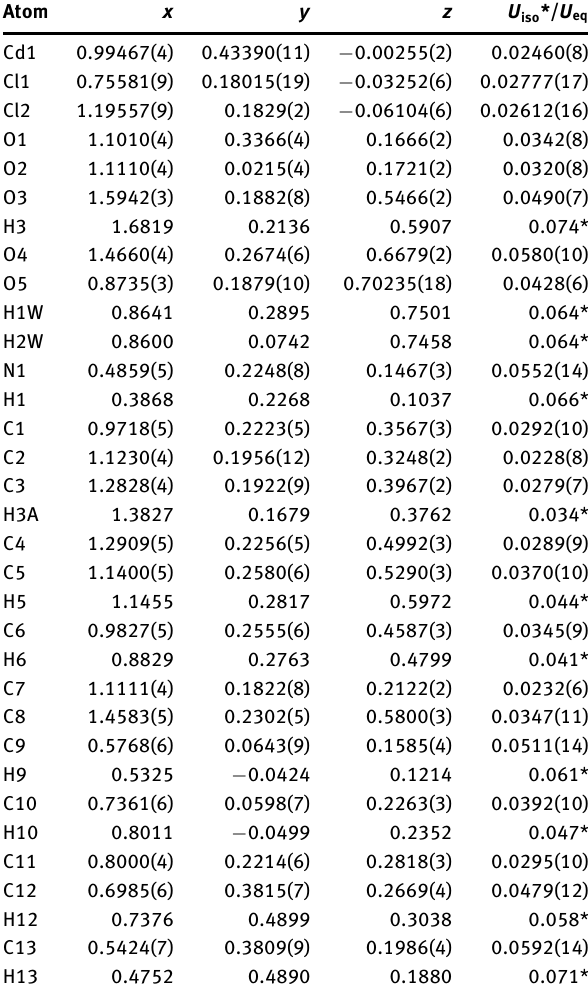
Table 2: Fractional atomic coordinates and isotropic or equivalent isotropic displacement parameters (Å 2